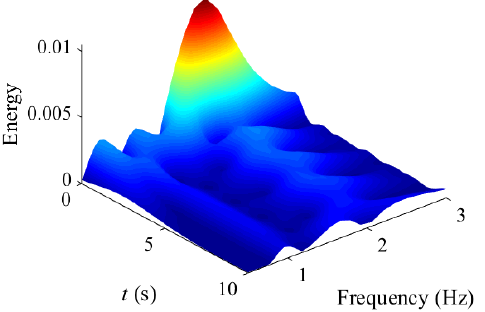
Figure 6. Time-response frequency graph ( ω 0 = π/5 rad/s; T = 1 s; α = β =